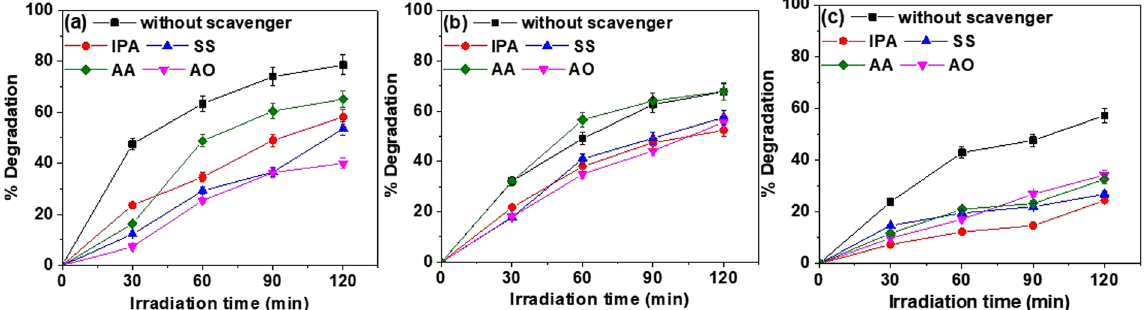
Figure 15. Effect of various scavengers on the degradation of ( a ) RhB, ( b ) MB and ( c ) MO dye with photocatalyst (10C800).